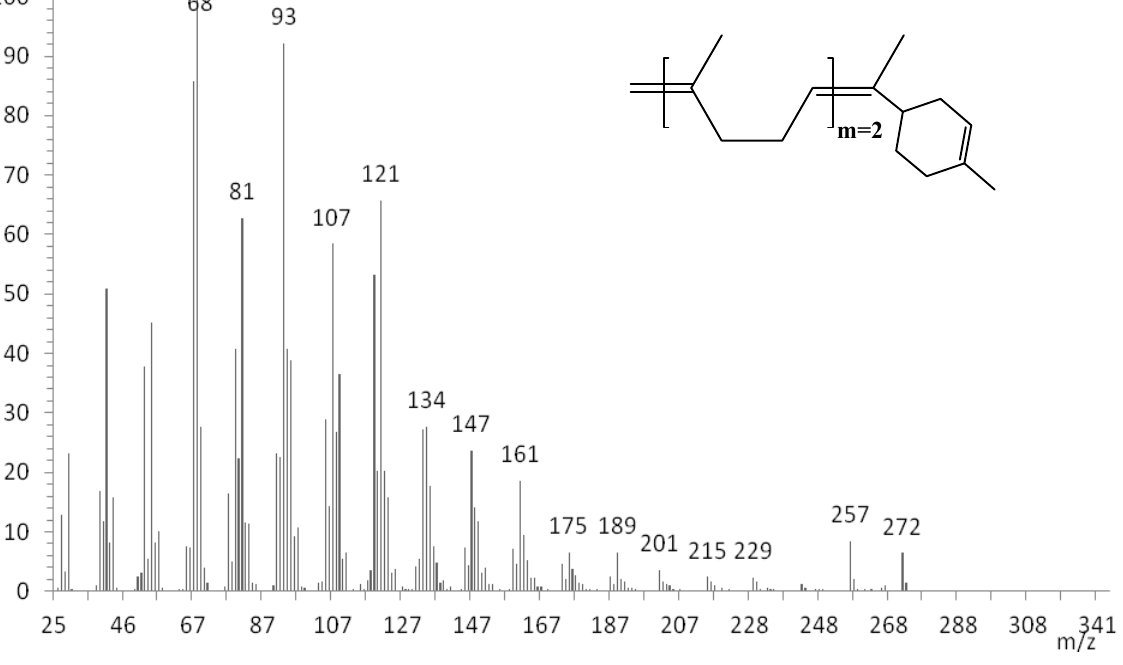
with m =2 ( m/z = 272, 67%) obtained during m